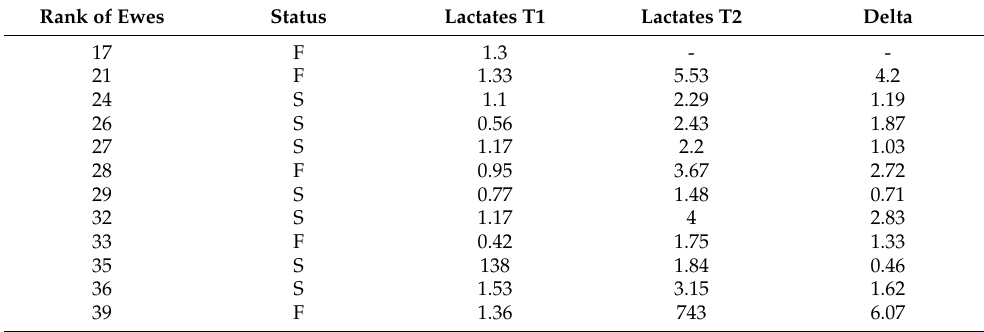
Table 4. Lactate levels at T1 (directly after anastomoses) and T2 (6 h after reperfusion). S = success, F =